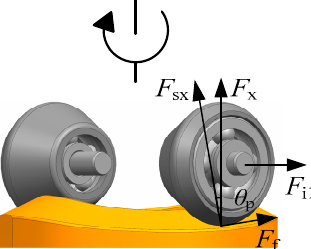
Figure 9. Force analysis of the cone rollers on the right driving set when it rotates from 45 degrees to 90 degrees.